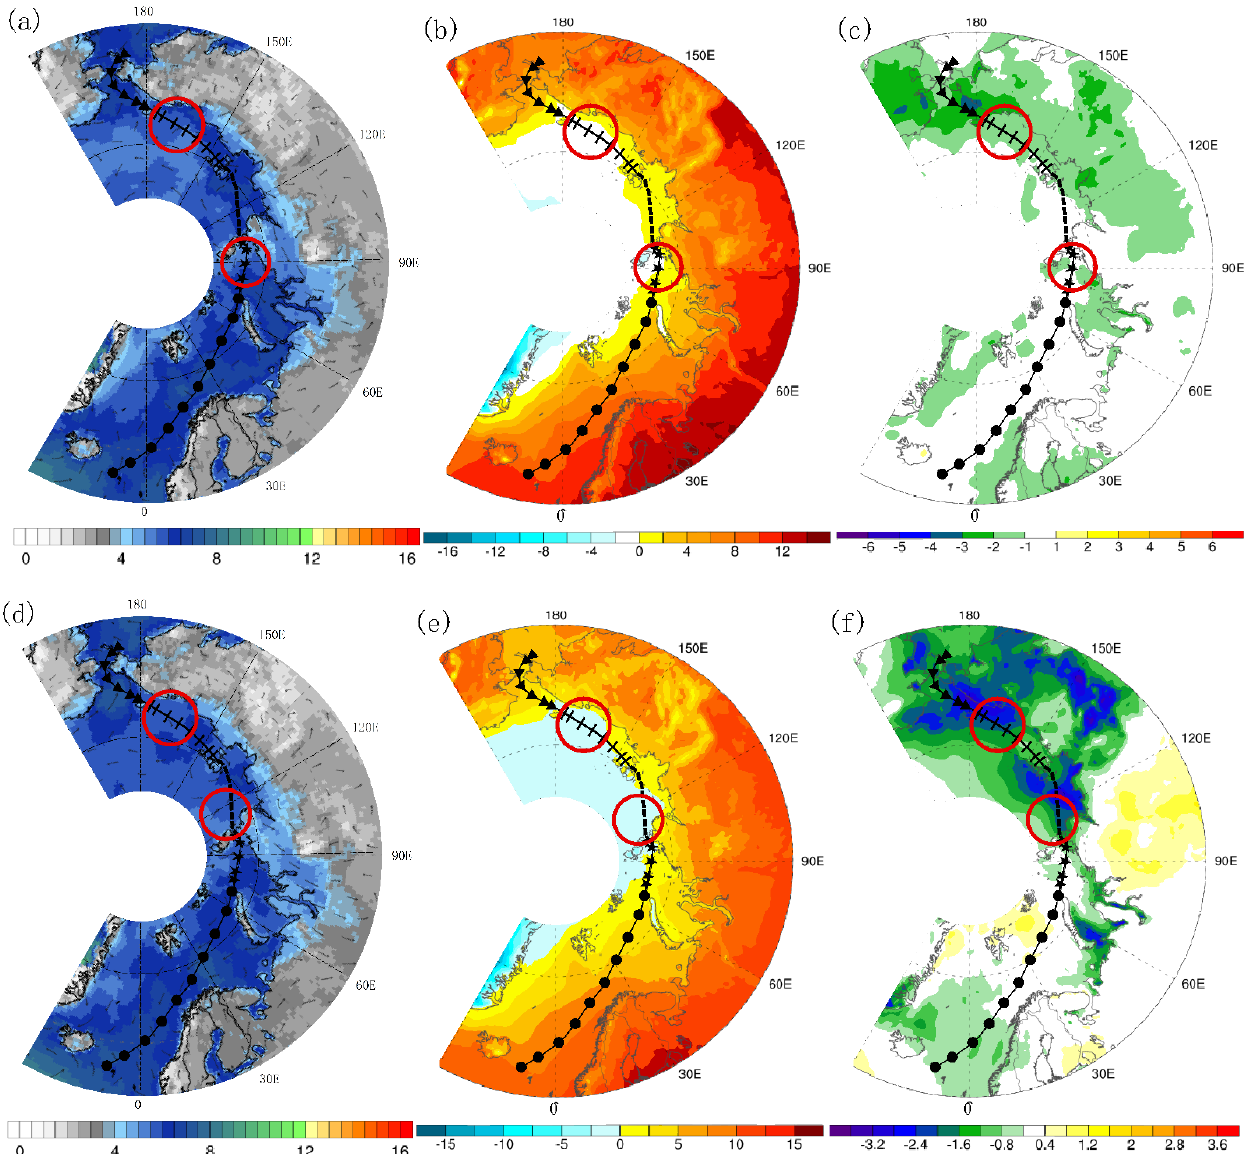
Figure 7. The average wind field ( a ), average temperature ( b ) and temperature anomalies ( c ) of the NEP in the Arctic summer (July–September) in 2000. The average wind field ( d ), average temperature ( e ) and temperature anomalies ( f ) of the NEP in the Arctic summer in 2001. The red circles indicate the throat areas that affected the navigation of the NEP in that year, the same below.